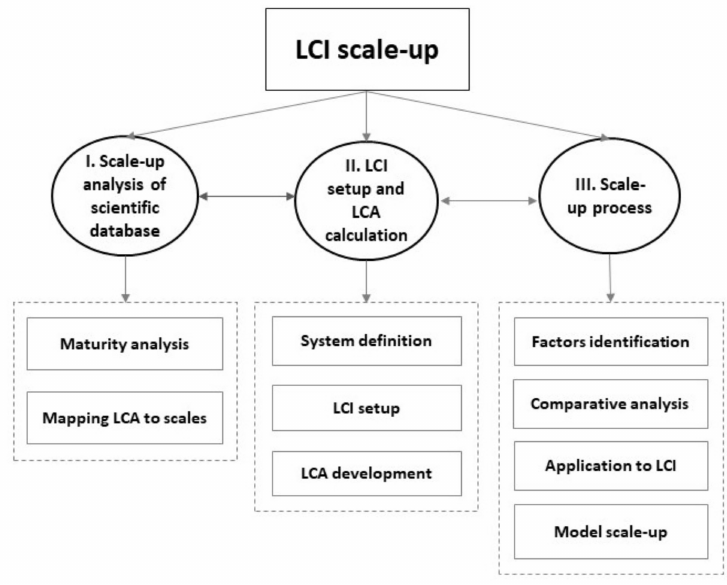
Figure 8. LCI scale-up